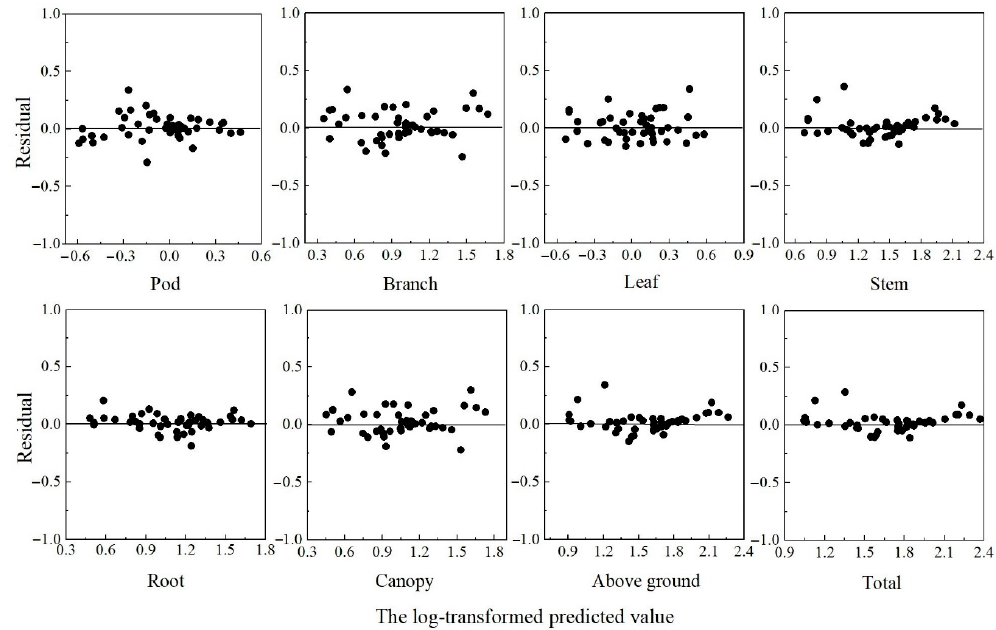
Figure 5. Residuals chart of the best model, system 3, with the predicted value of logarithmic transformation as abscissa.